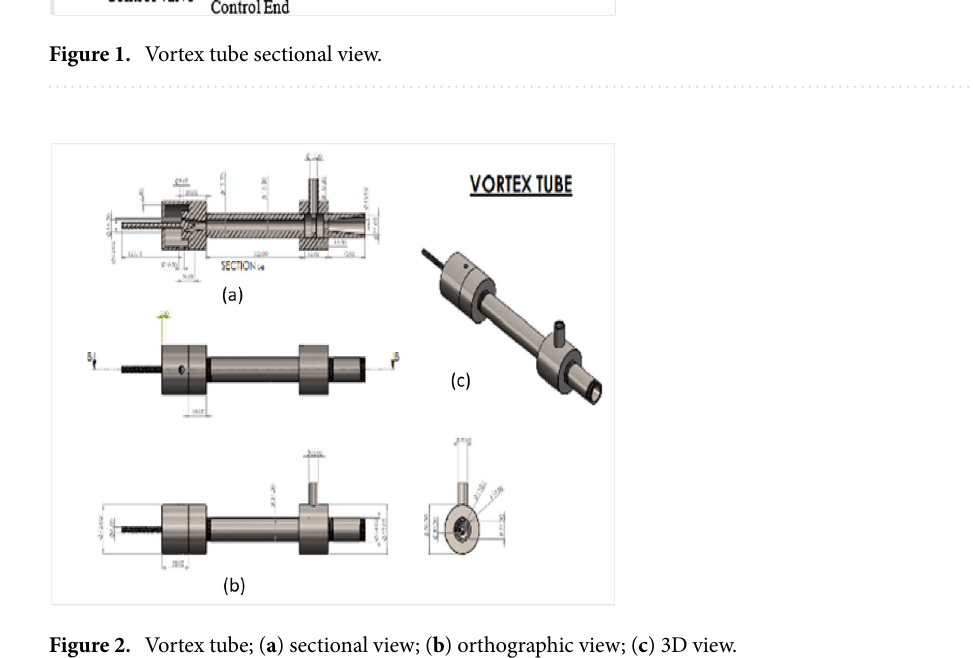
Figure 2. Vortex tube; ( a ) sectional view; ( b ) orthographic view; ( c ) 3D